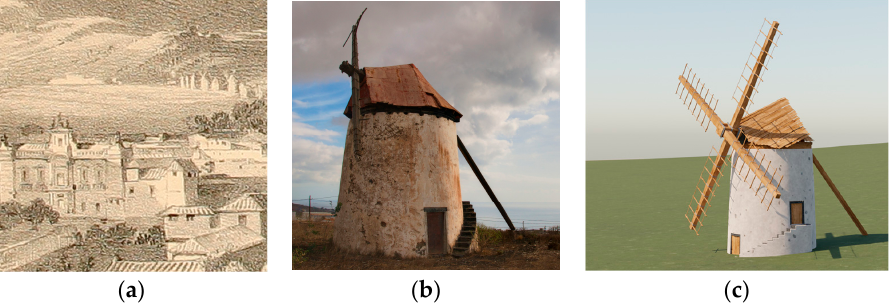
Figure 20. 3D modelling of a windmill. ( a ) Drawing of windmills on the outskirts of the city [48], ( b ) photograph of a windmill [49], and ( c ) 3d model.